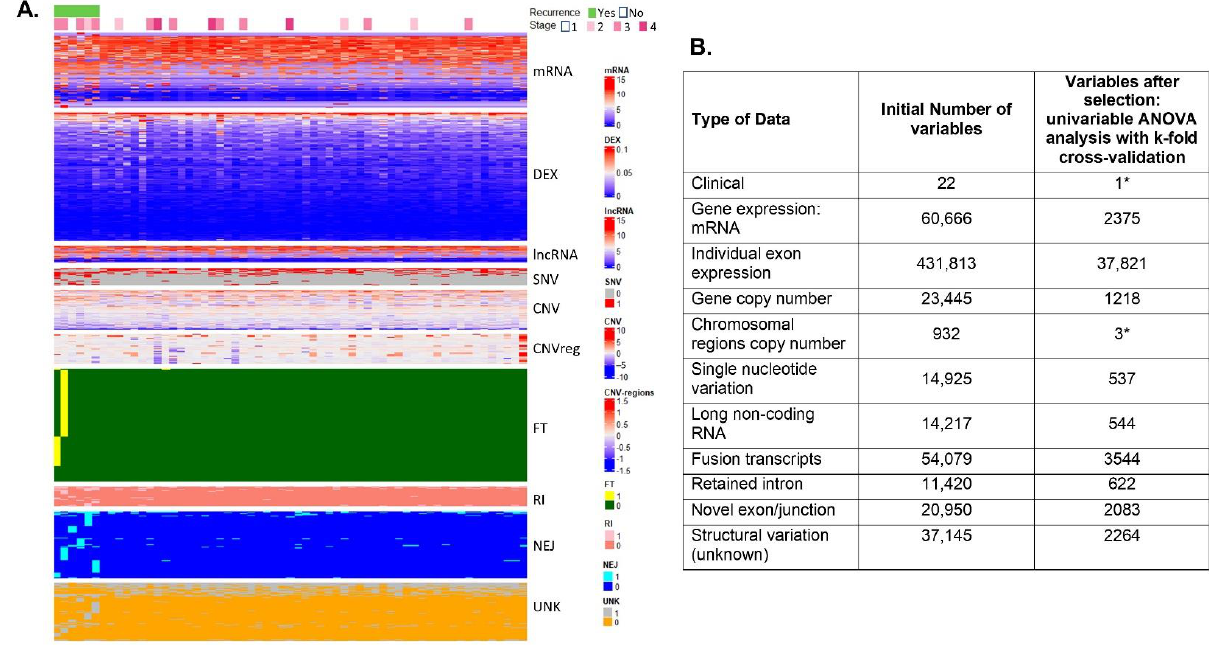
Figure 2. Included patients. ( A ) Heatmap of selected variables after univariate ANOVA analysis. Representation of the significant variables after univariate analysis ( p < 0.05) for different types of genomic data. Recurrent cases are at the left side of the panel (under the light green bar); non-recurrent cases are at the right (white bar). Of the 22 clinical features introduced in the lasso analysis, only stage was informative for recurrence (upper part of the panel, color coded from 1 to 4). Transcriptome: DEX: exon expression; lncRNA: long non-coding RNA; Exp: gene expression. Genomic variation: SNV: single nucleotide variation; CNV: gene copy number by gene; CNVreg: copy number by chromosomal region; Structural variation: FT: Fusion transcripts; RI: Retained intron; NEJ: Novel exon/junction; U-SV: Unknown SV. At the right side of the panel are the labels and the color-coded range of values for all genomic variables. ( B ) Variable selection and variables after univariate analysis. To reduce the number of variables, we used univariate analysis of all data with ANOVA to select the variables that were more informative for prediction of response, with a p -value < 0.05 (3rd column). * Lasso regression was performed directly with no pre-reduction with ANOVA because the smaller number of variables in two types of data: clinical data and copy number by chromosomal region. Graphics were generated with R package ComplexHeatmap